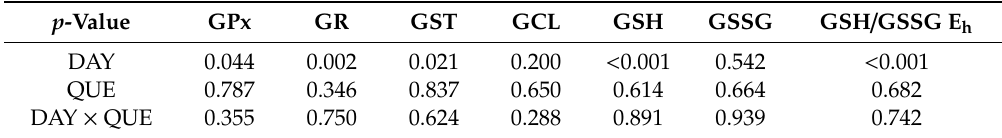
Table 5. Significance levels for treatment e ff ects on the glutathione redox system in the duodenal mucosa of piglets at d5 and d14post-weaning (DAY), fed a diet containing either 0, 100, 300, or 900 mg quercetin / kg diet (QUE) during the first 14d post-weaning ( n =